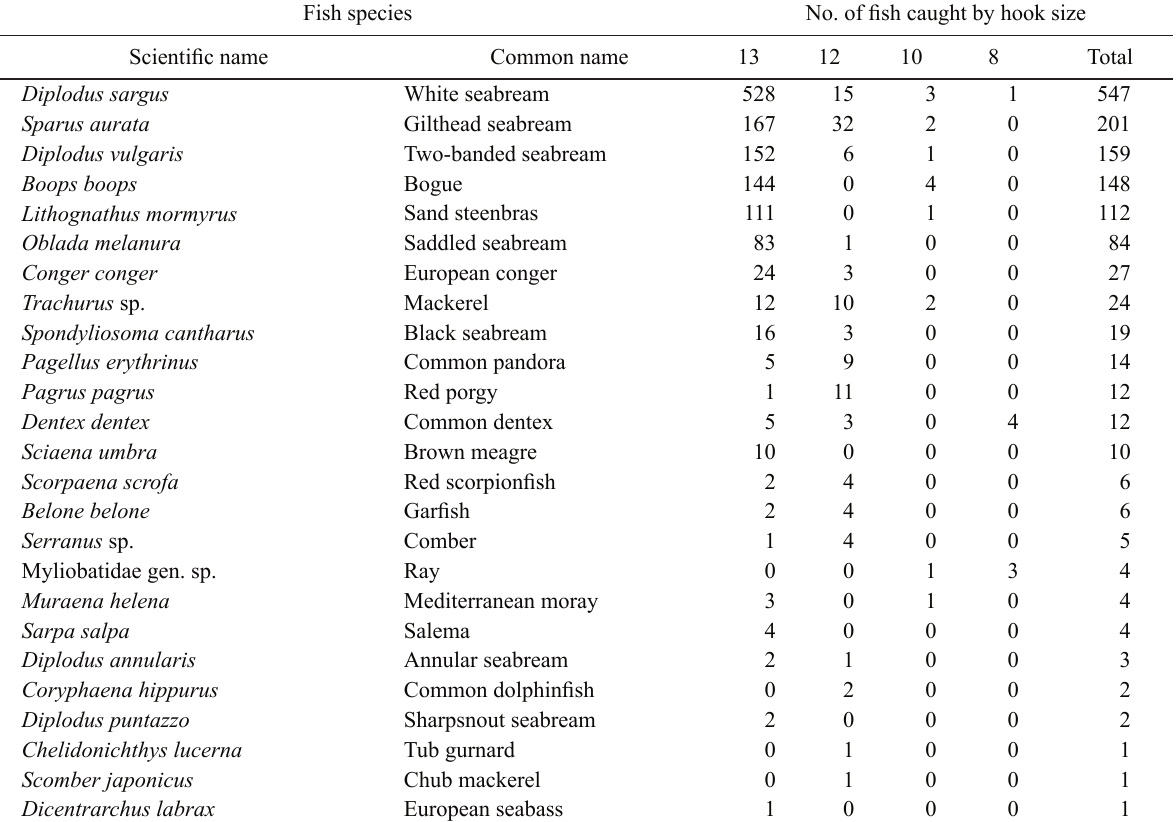
The catch composition and catch in numbers by hook size of a longline fishery in the Foça